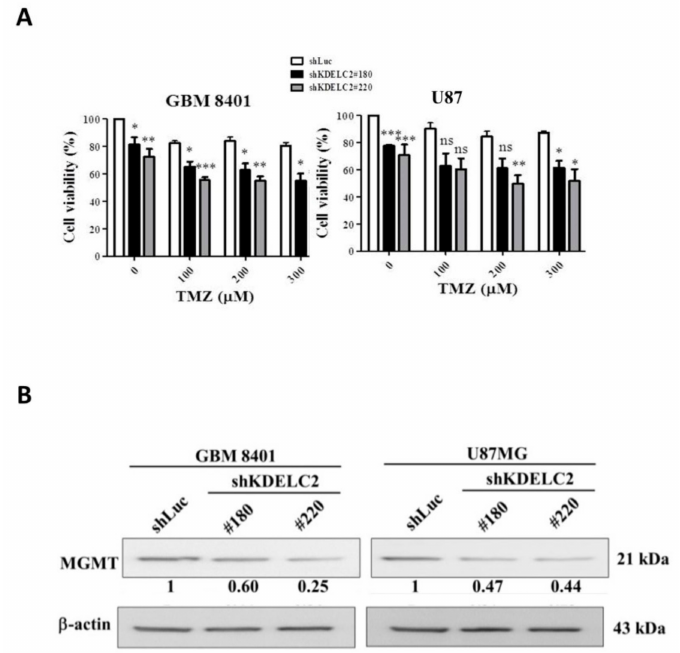
Figure 10. KDELC2 knockdown increased TMZ sensitivity by inhibiting MGMT expression. ( A ) Combination of shKDELC2 transfection and 300 µ g TMZ had the least glioblastoma (GBM) viability. ( B ) Low MGMT expression was noted in shKDELC2-transfected GBM. Bars, means ± SEM.